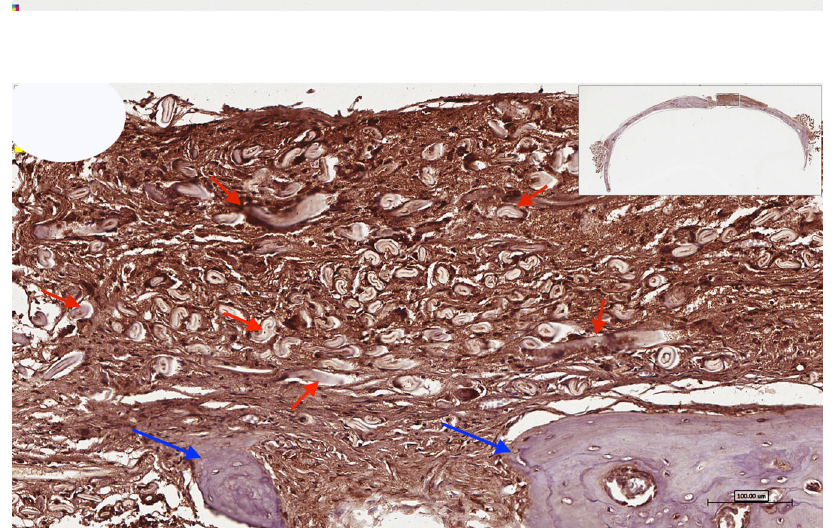
Fig. 13 Photomicrograph of osteopontin (OPN) immunohistochemistry staining of critical size calvarial defect treated with DSM/SCPC/ hBMSC